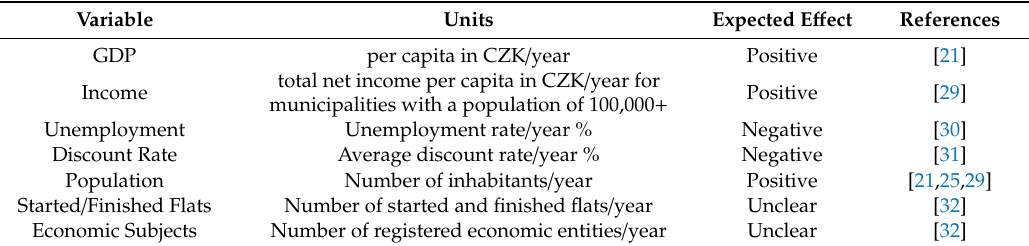
Table 1. Land price drivers—expected e ff ects of